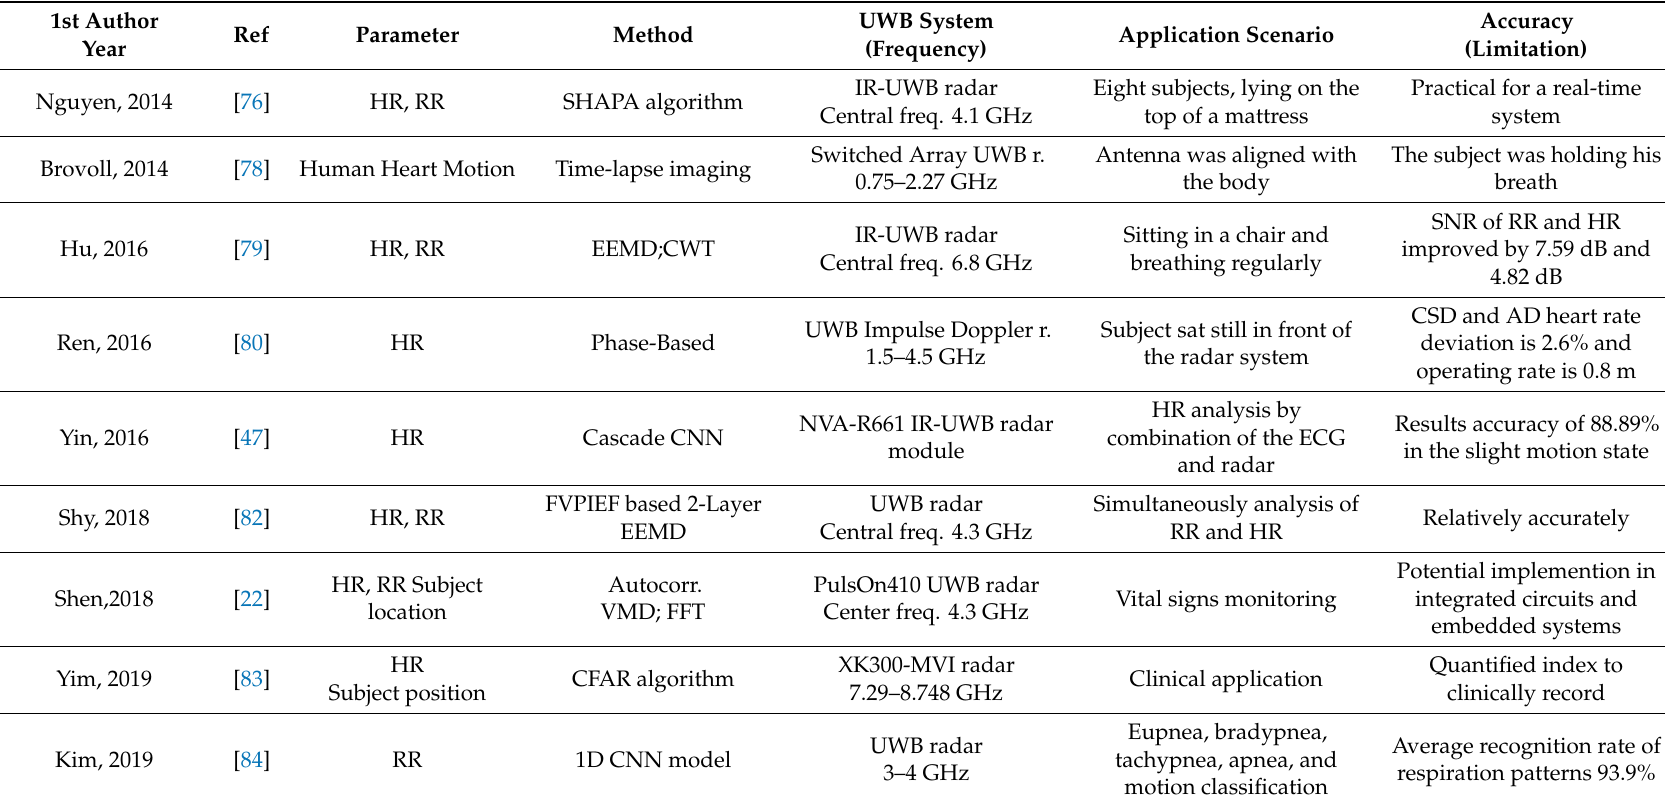
Table 1. Summary of UWB vital signs monitoring application reported in the